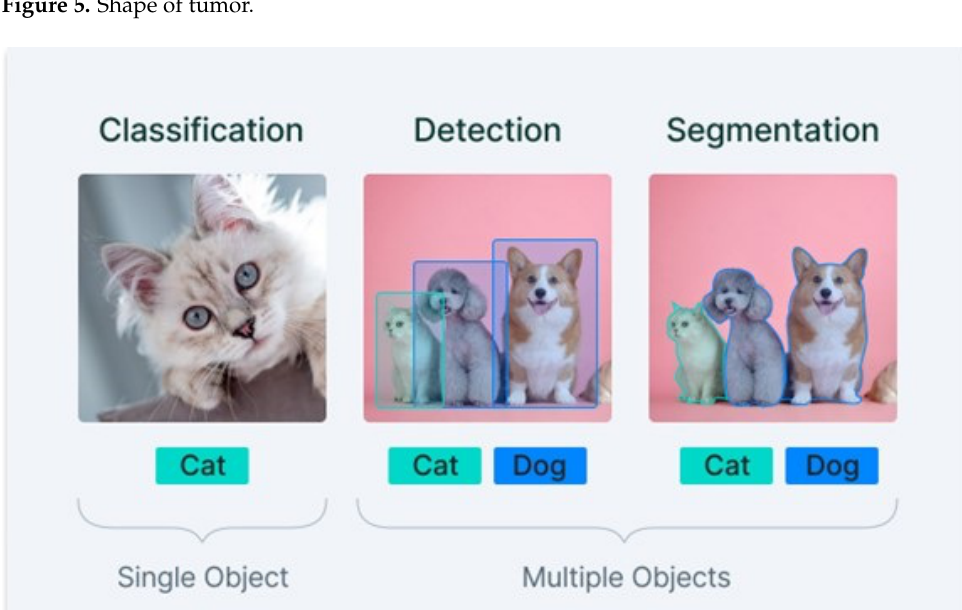
Figure 6. Tasks of computer